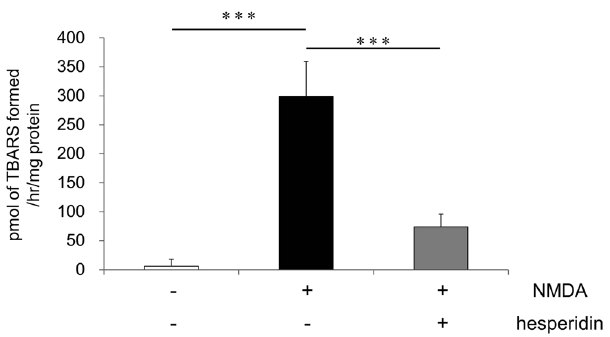
Figure 5. Hesperidin attenuated lipid peroxidation after NMDA injury. The amount of MDA in the retina was quantified using a TBARS assay 6 hours after the intravitreal injection of PBS, NMDA or NMDA with hesperidin. The average amount of MDA was calculated and is shown per mg of retinal protein. ( n = 6 each) Data represent mean ± SD. *** p <